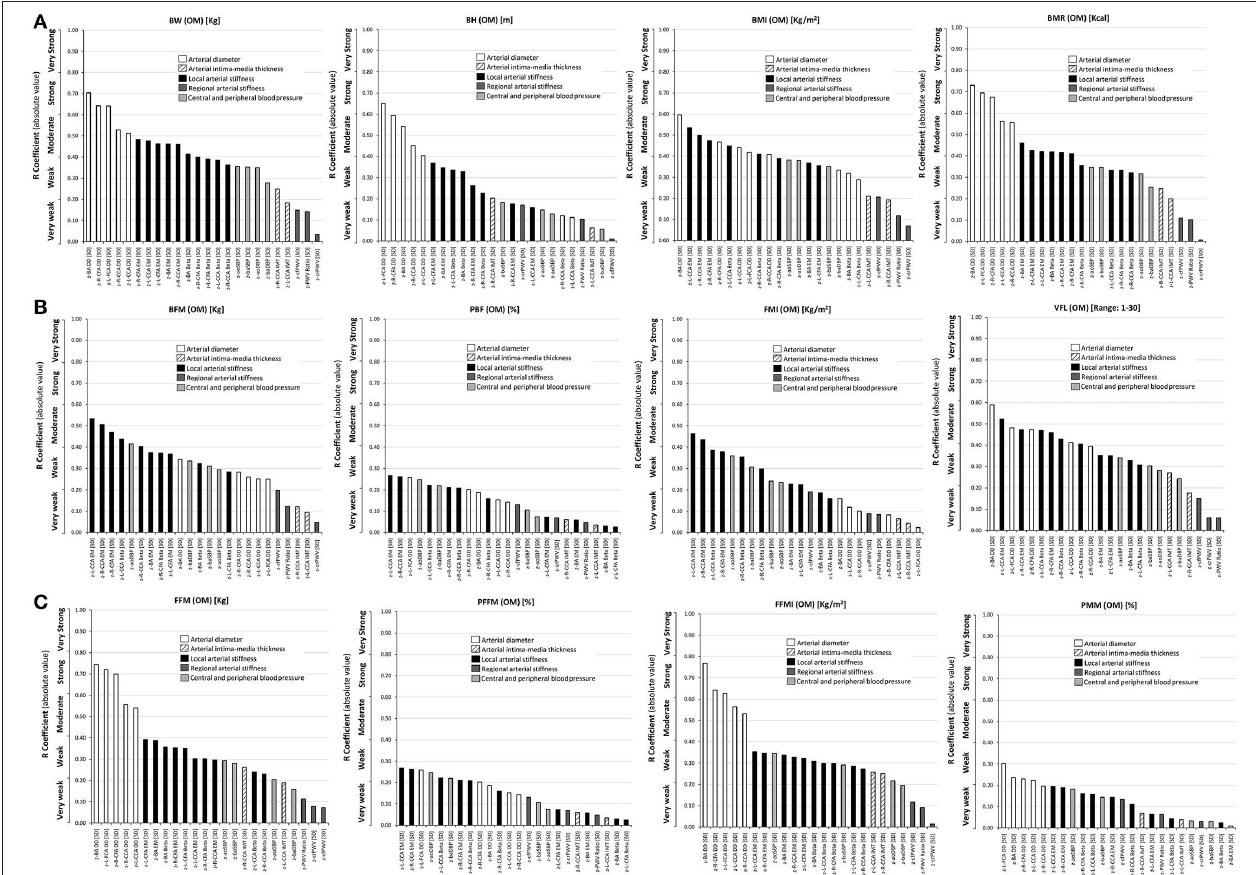
FIGURE 2 | Simple (Pearson, r) correlation coefficients (absolute value), ranked from highest to lowest r value, for: (A) Top: classical anthropometric indexes (BW, BH, BMI, BMR), (B) Middle: body fat mass indexes (BFM, PFM, FMI) and VFL, and (C) Bottom: fat-free mass indexes (FFM, PFFM, FFMI, PMM), and cardiovascular z-scores. Variables were obtained with the Omron BIA device (OM). Abbreviations as in